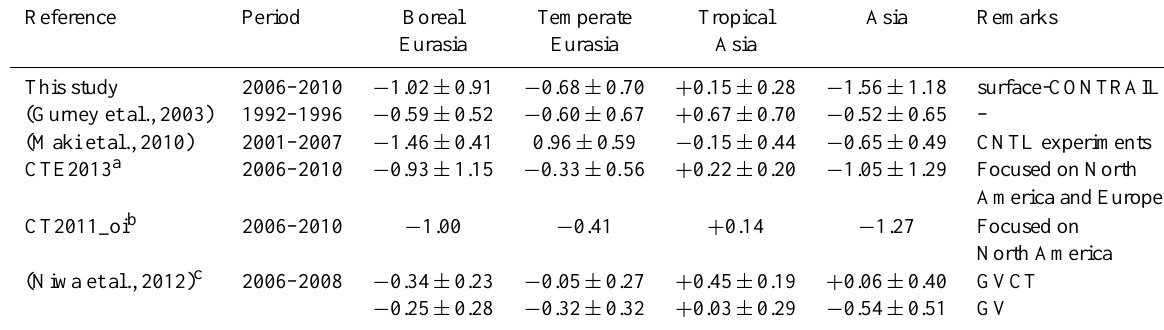
Table 7. Comparison of the inverted Asia terrestrial ecosystem carbon fluxes (in PgCyr − 1 ) from this study with previous studies.